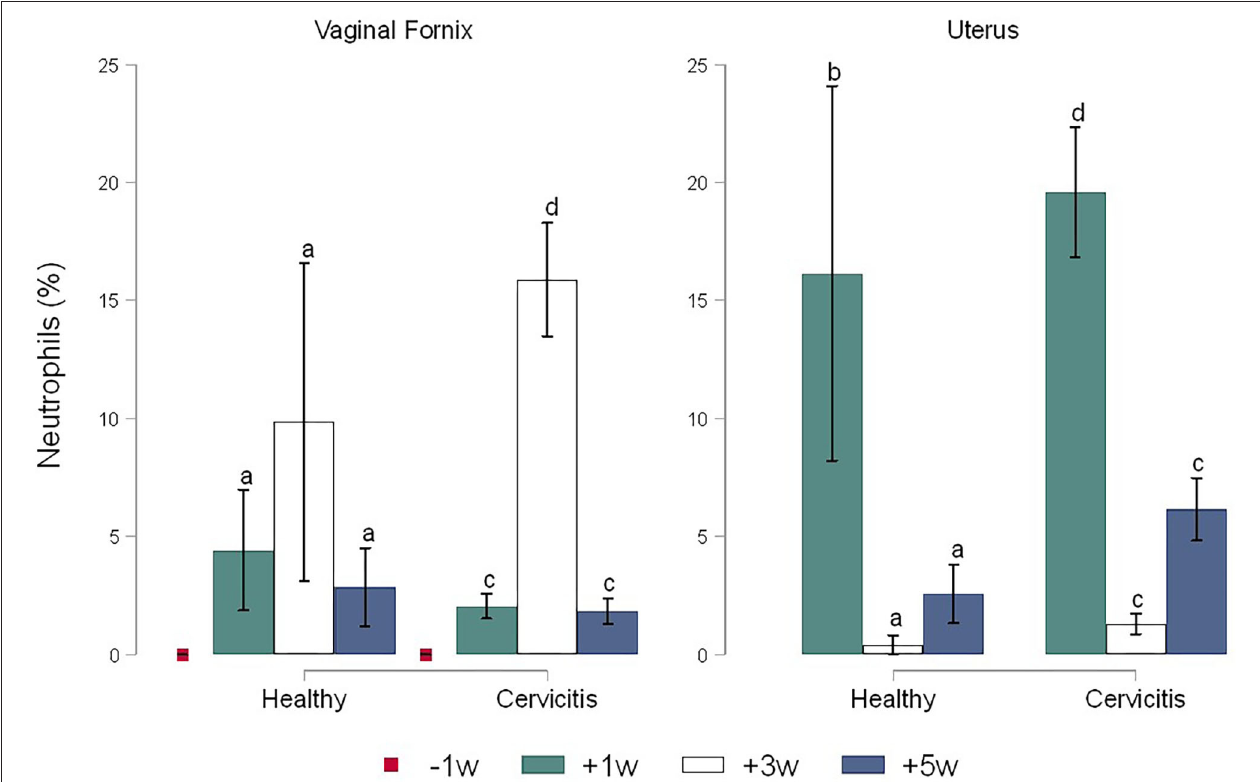
FIGURE 2 | Time-course variations in the pre-and post-partum percentage of neutrophils in the vaginal fornix and uterine mucus of cows ( n = 26) defined as clinical cervicitis cows ( n = 19) and healthy cows ( n = 7) from three dairy herds in Quebec in 2016. Time-course variations (weeks − 1w + 1w + 3w + 5w) of neutrophils percentage, time-course differences are indicated with superscript a-b (for healthy cows), and c-d (for clinical cervicitis cows). Means without a common superscript differed ( P < 0.05).